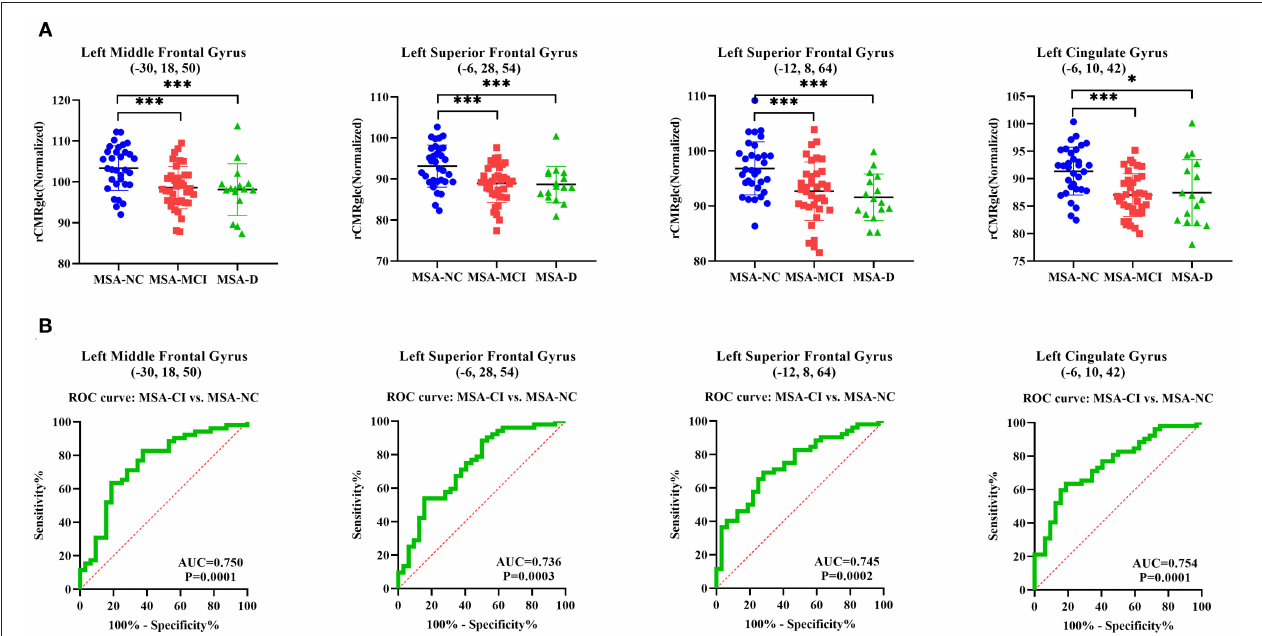
FIGURE 2 | Differences of normalized regional cerebral metabolic rate of glucose (rCMRglc) in representative regions across three cognitive statuses illustrated by post-hoc ANOVA and differential diagnostic utility of rCMRglc in corresponding regions for MSA-CI and MSA-NC. (A) Normalized rCMRglc obtained within a spherical VOI (4-mm radius) with the center in peak voxel of left middle frontal gyrus cluster ( − 30, 18, 50), left superior frontal gyrus cluster ( − 6, 28, 54), left superior frontal gyrus cluster ( − 12, 8, 64), and left cingulate gyrus cluster ( − 6, 10, 42) were significantly different among three cognitive statuses. *** p < 0.001; * p < 0.05. (B) The area under ROC curve of using rCMRglc in the aforementioned regions to distinguish MSA-CI from MSA-NC were 0.750, 0.736, 0.745, and 0.754,